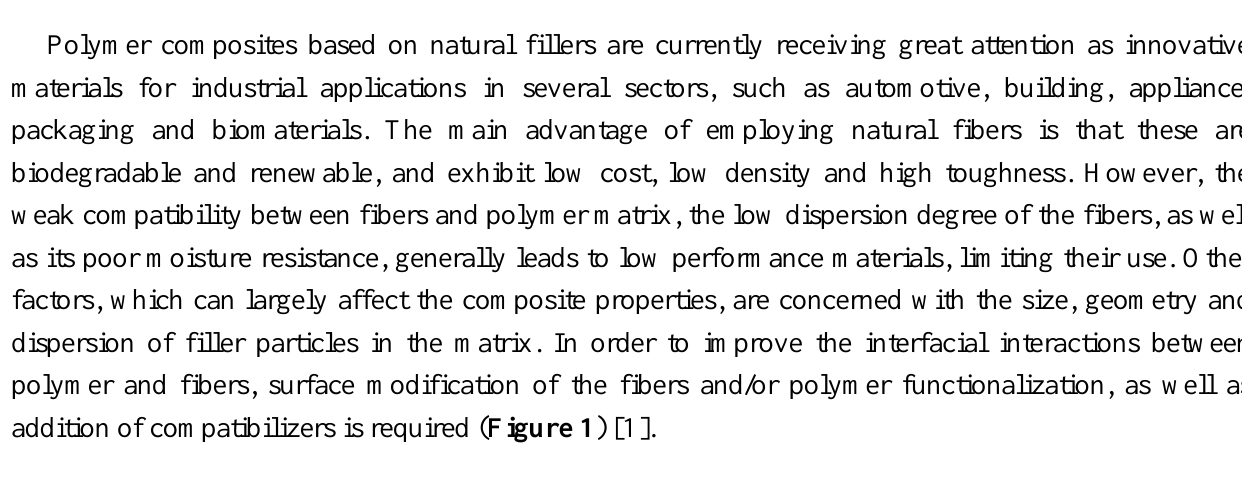
Figure 1. Structure-processing-property relationships of thermoplastic composites with natural